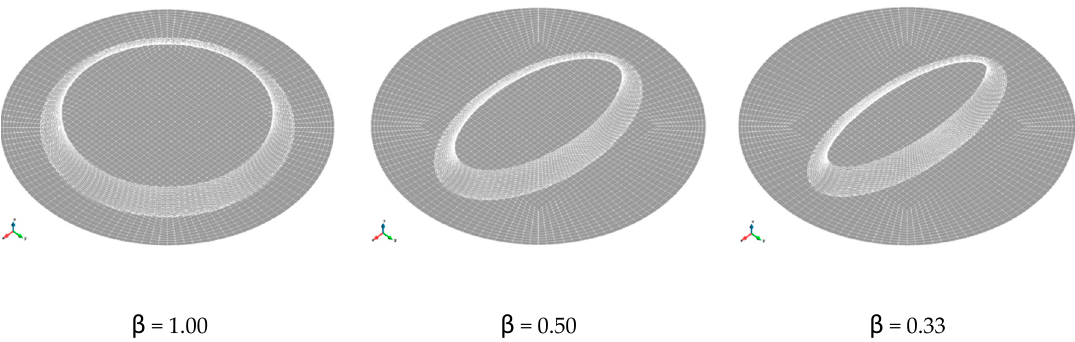
Figure 3. Geometrical models and finite element meshes of the bulge test for the different analyzed dies.